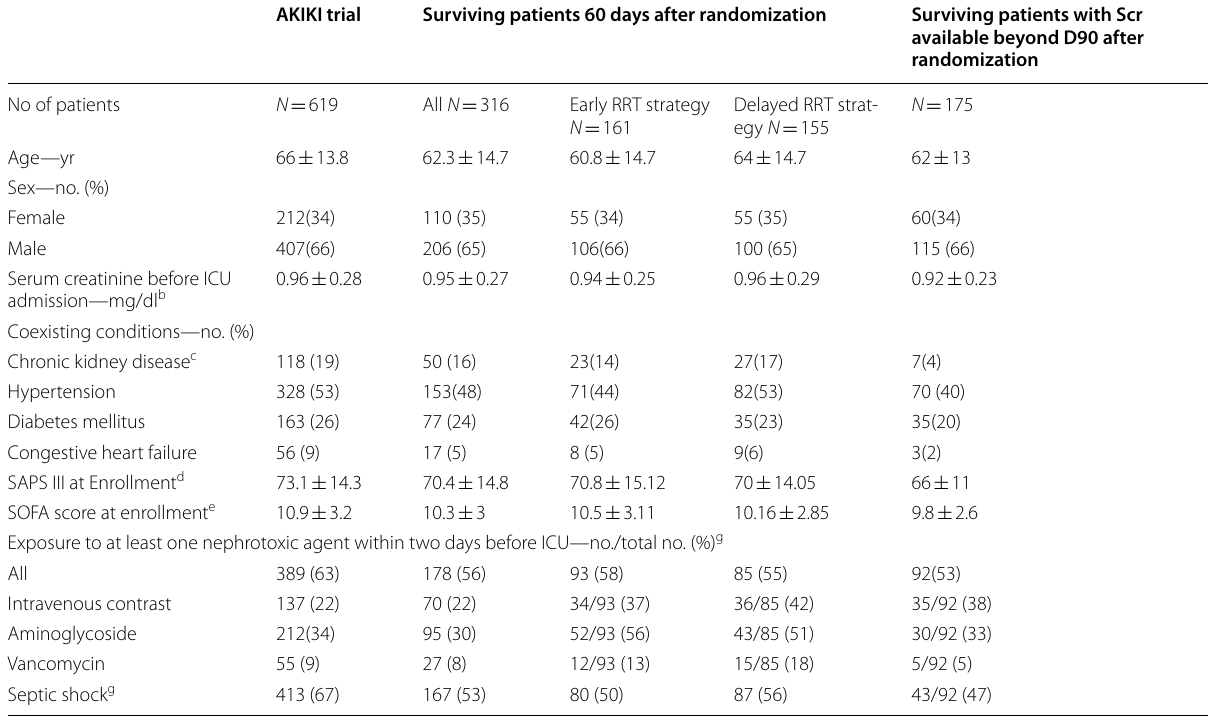
Table 1 Characteristics of the patients at baseline